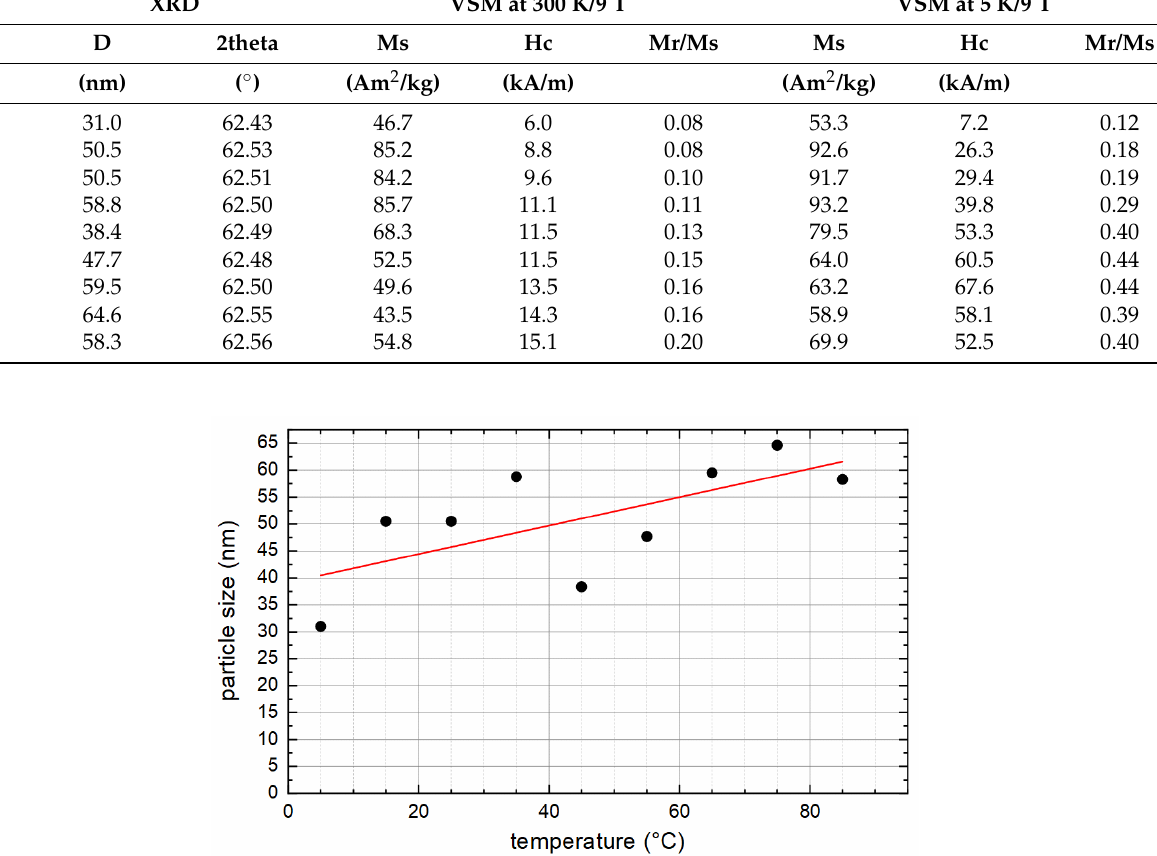
Figure 2. Particle diameter from XRD as a function of the synthesis temperature. Line serves as a guide to the eye only.